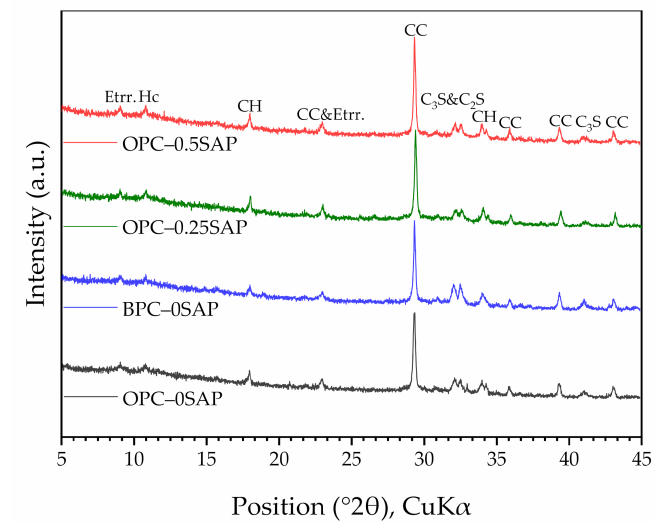
Figure 11. X-ray diffraction (XRD) spectra of the mixed cement paste at 28 days. Ettr.: ettringite; Hc: hemicarboaluminate; CH: calcium hydroxide; CC: calcite.